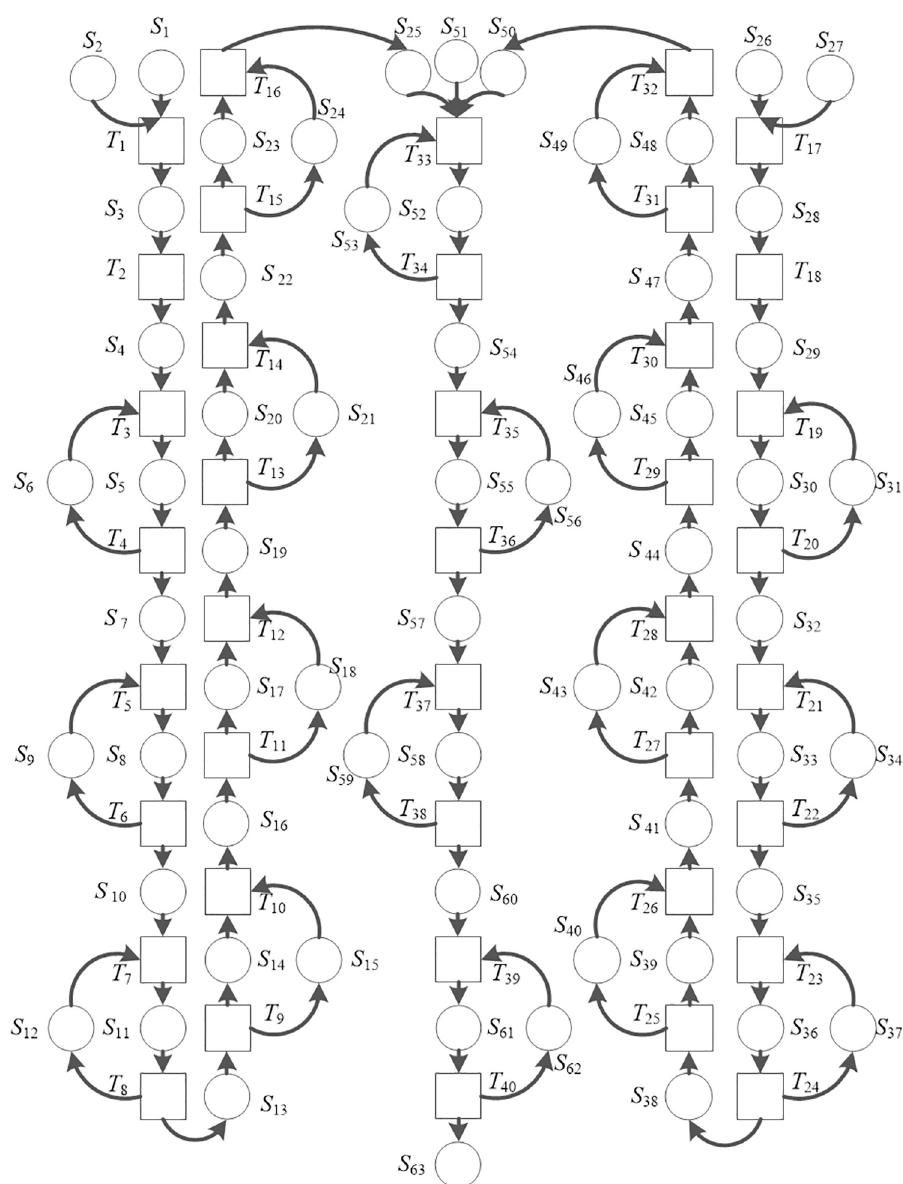
Fig 6. TdPN model of bearing plant logistics